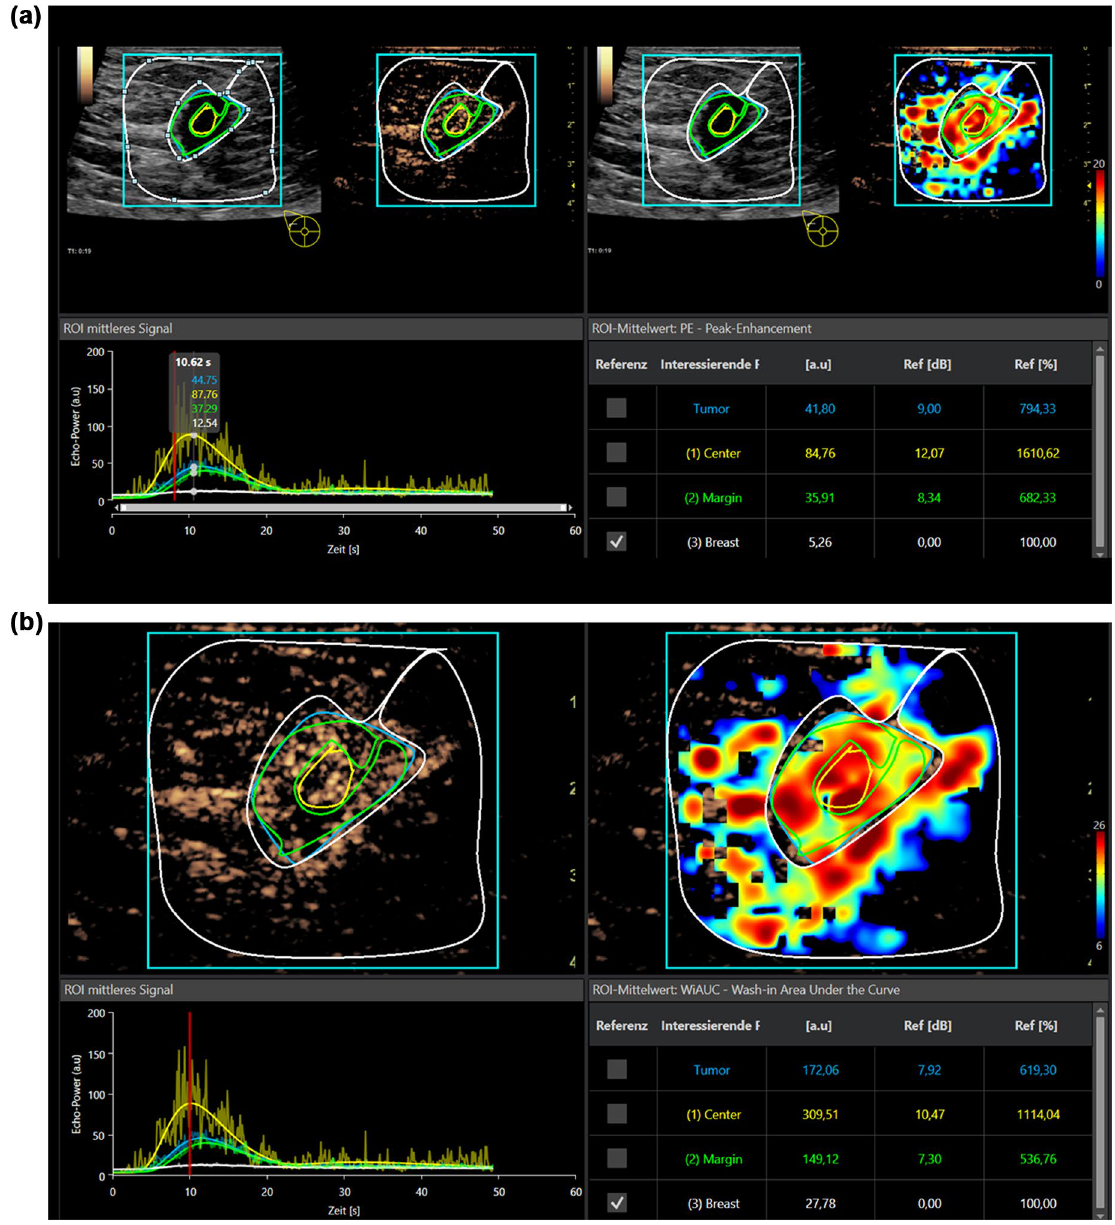
Figure 1. ( a ) Evaluation of dynamic CEUS micro-vascularization of a malignant breast lesion after i.v. application of 2.4 ml ultrasound contrast media using external perfusion software VueBox. The VueBox screen is divided into four sections. Up left, the original CEUS image with the manually drawn Regions of Interest (ROI). Up right, the perfusion imaging with false colors showing hyperperfusion in red shades. Down left, the Time Intensity Curve analysis (TIC) of the Regions of Interest and down right the numeric values of the regions. The healthy breast tissue is taken as reference. Each perfusion parameter is calculated in an extra step. Case of a small malignant breast tumor. Contrast enhanced evaluation up to 60 s for PE. In parametric imaging irregular red and yellow false colors for tumor micro-vascularization, blue for the surrounding tissue. High and fast wash in and rapid wash out in time intensity curve analysis (TIC) as criteria for malignancy. ( b ) Same case of a malignant breast lesion with evaluation of wash in area under the curve (AUC). ( c ) Same case of a malignant breast lesion with evaluation of Rise Time (RT). Less differences are seen in parametric imaging compared to the surrounding tissue. ( d ) Same case of a malignant breast lesion with evaluation of Time to Peak (TTP), with hardly any differences in parametric imaging compared to the surrounding